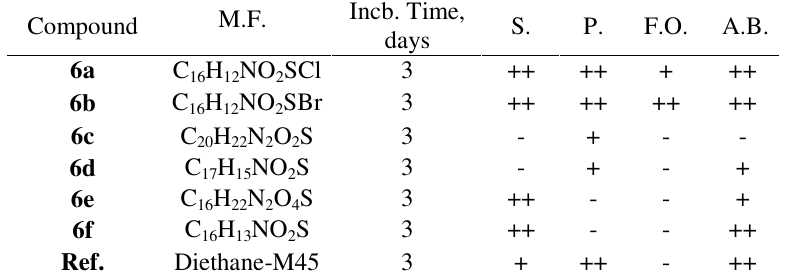
Table 3. Antifungal activity of 2-ketophenyl-3-substituted aryl-1-thiazolidin-4-one. Compound M.F.